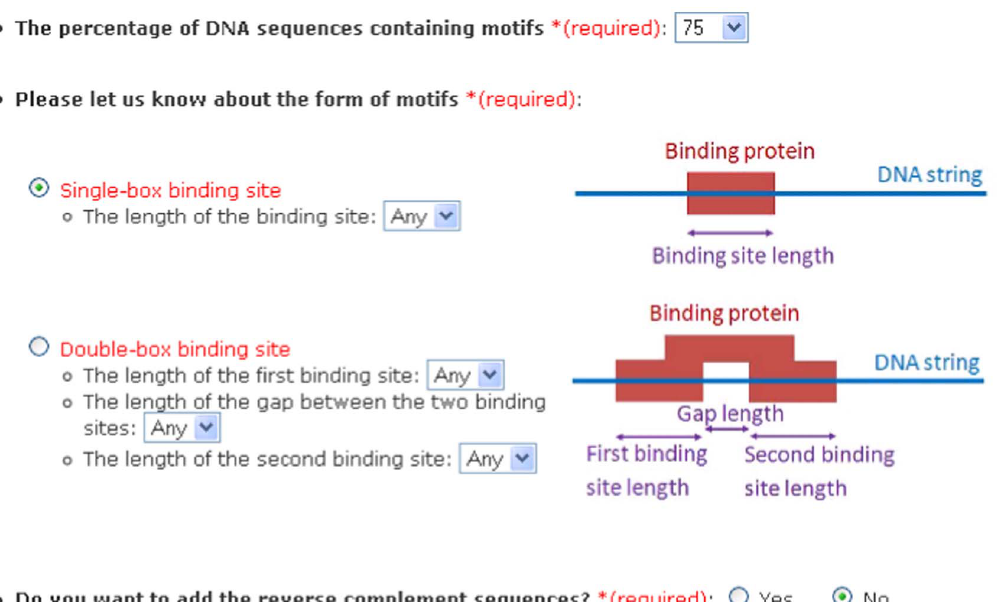
Figure 1. Parameters for DNA sequences. The set of required parameters for DNA sequences. The first parameter is ‘‘ quorum percent ’’ which is the minimum percentage of the input sequences containing motifs. The second parameter allows users to choose the structure of motifs.